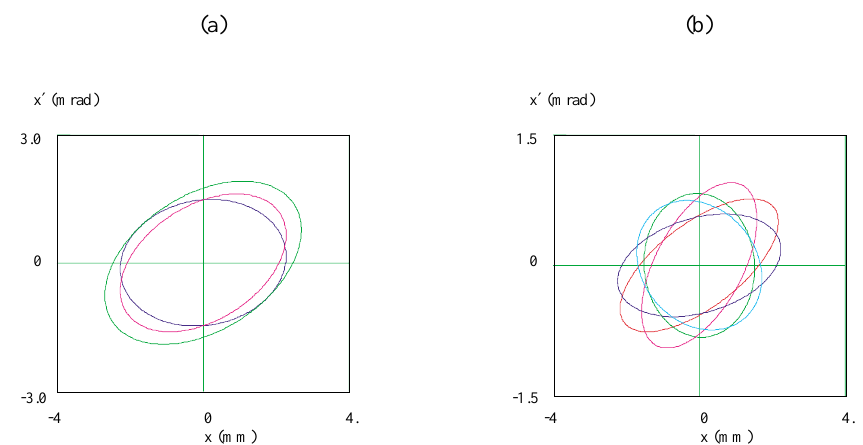
FIG. 11. (Color) Transverse ellipses of mismatched beam (mismatched factor is 1.4) at the entrance (a) and exit (b) of the periodical focusing channel. The left figure shows the matched ellipse (magenta), mismatched ellipse (blue), and effective emittance (green).